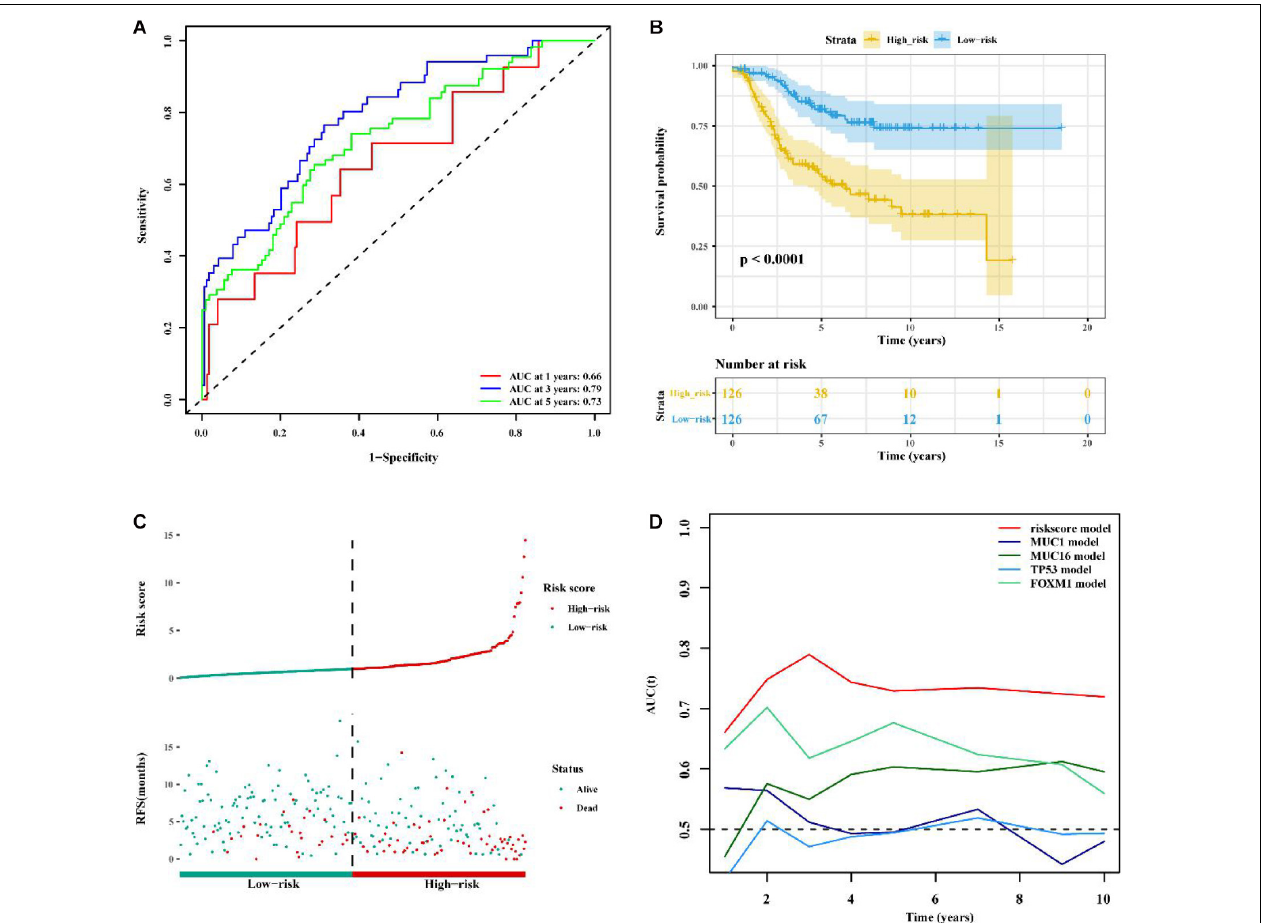
FIGURE 6 | Comparison of prognostic performances between the lncRNA signature and known prognostic biomarkers and validation using the GSE21653 cohort. (A) The ROC curve to verify the prediction efficiency of the lncRNA signature. (B) Kaplan-Meier curve for the OS of BC patients in the high- and low-risk groups. (C) The risk-score distribution and duration of RFS of the lncRNA signature in the GSE21653 validation cohort. (D) Time-dependent ROC curve to compare prediction efficiency between the lncRNA signature and the known prognostic biomarkers.